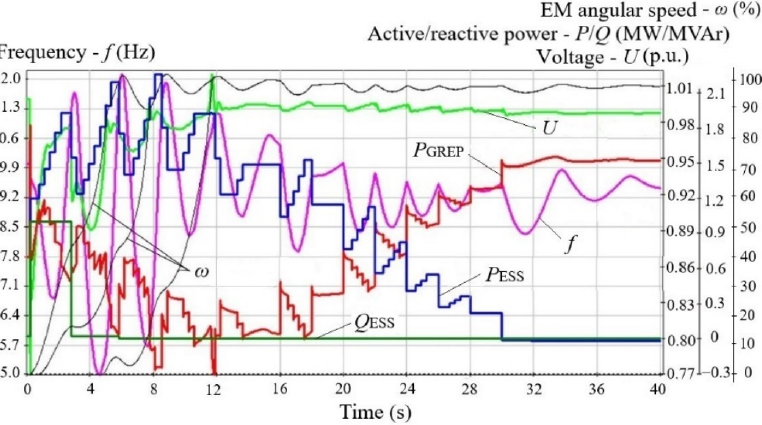
Figure 4. Transient in the case of a group starting of electric motors by a single GREP.